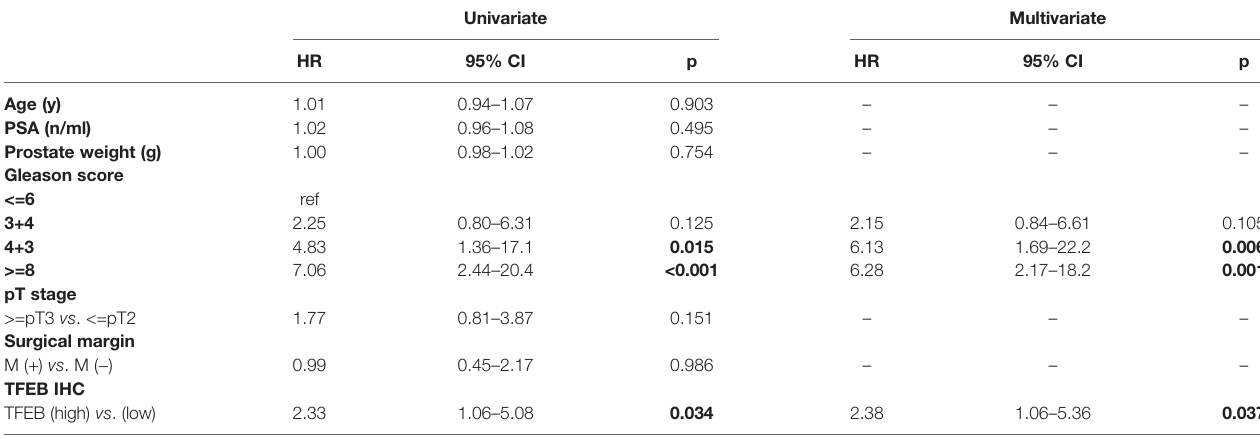
TABLE 2B | Univariate and multivariate analysis of clinicopathologic factors with metastasis-free survival. Multivariate Cox regression model fi tted with factors that showed signi fi cance in univariate analysis. Univariate